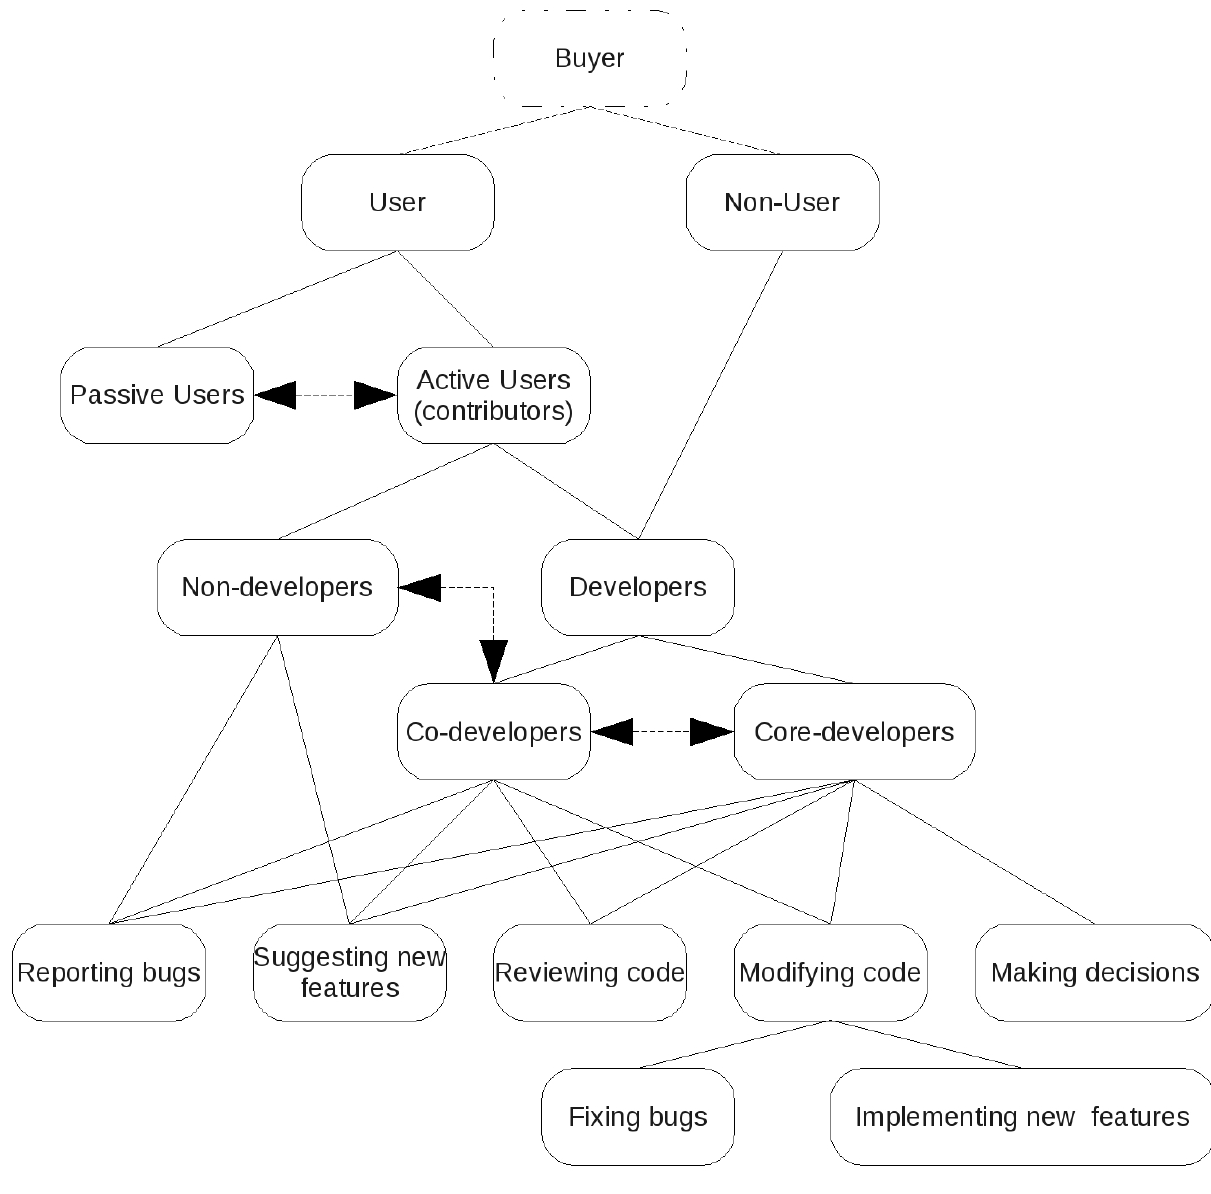
Figure 2. Open source software development